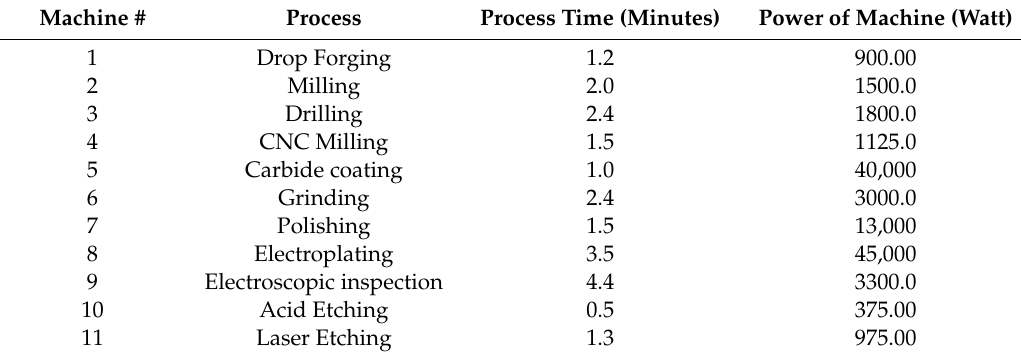
Table 3. Manufacturing process plan of scissor along with the power of machines.